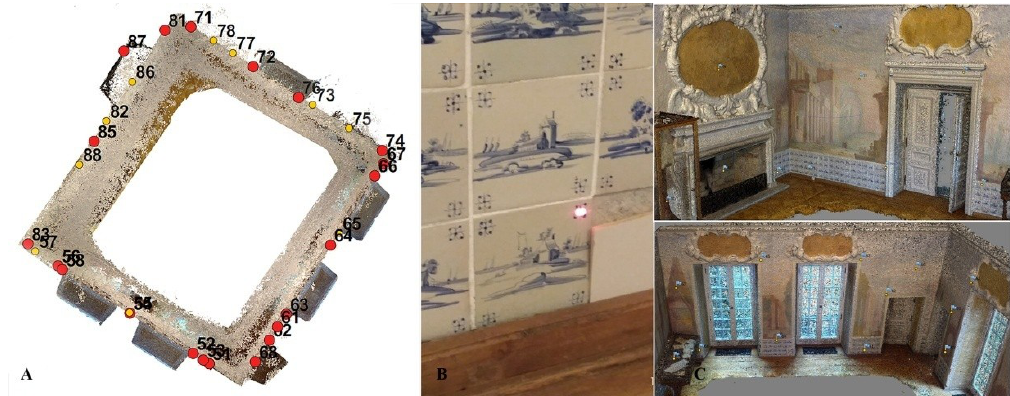
Figure 2. The distribution of control and check points used in TLS and images orientation. A) Sketch of point distribution, B) The example of natural measured point, C) The example of marked points on dense point